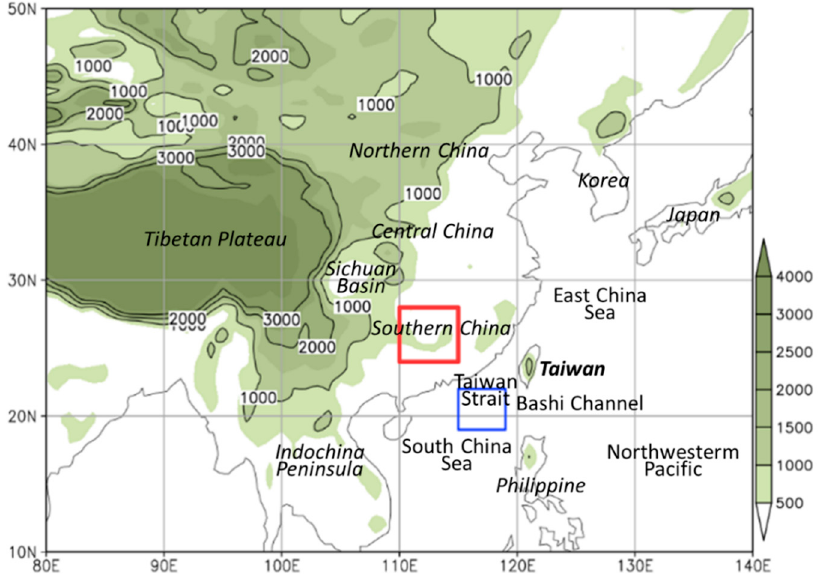
Figure 1. A map and topography (m, color) in East Asia. The red box (24°–28° N, 110°–115° E) shows the region to compute pressure fall and its related diagnosis, and the blue box (19°–22° N, 115°–119° E) is the region to compute mean flow upstream of Taiwan. Table 1. Mei-yu heavy rainfall events (in May-June) that reached a peak daily rainfall amount of ≥ 350 mm for at least three days in a row during 1993–2020.